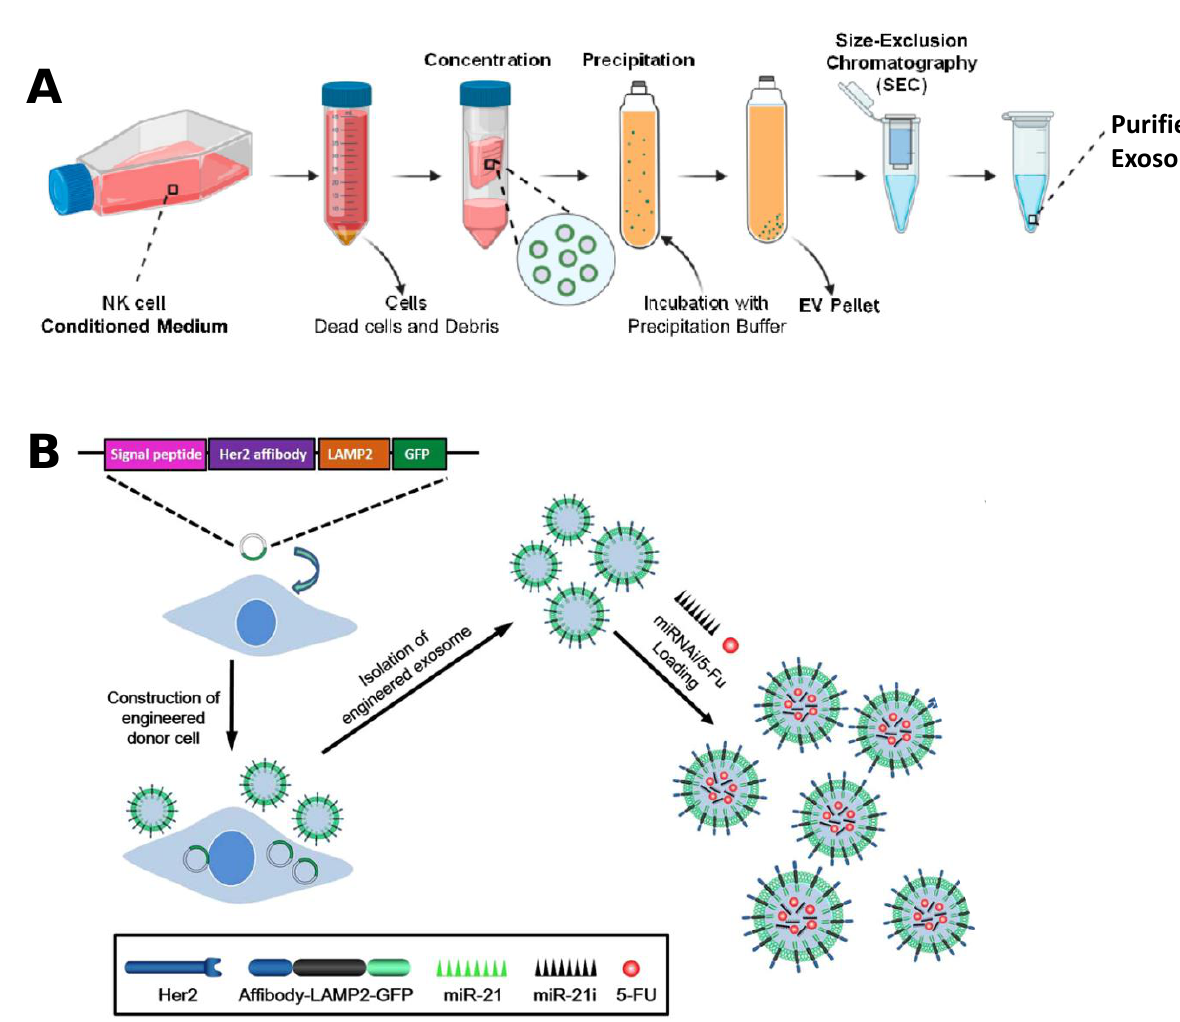
Figure 3. ( A ) The diagram describes the NKExos production process diagram. After 72 h of culture, NK92MI cells were removed by differential centrifugation. Finally, NKExos was concentrated and purified [92]. Copyright: © 2021 by the authors. ( B ) Preparation flow chart of engineered exosome nanocapsules based on 5-FU and Mir-21i. Her2 fuses with LAMP2 to form HCT-116 5FR cells. Her2-lamp2 fusion protein promotes targeted cellular uptake through EGFR receptor-mediated endocytosis in HCT-116 cells. 5-FU and Exo were mixed by electroporation, and 5-FU and Mir-21i were packaged into engineered exosomes and incubated together to form a co-delivery system (THLG-EXO/5-FU/Mir-21I) [93]. Copyright 2020, Springer Nature. Exosomes have more prominent features than LNPs including nucleic acid delivery, protection of therapeutic substances from degradation, elimination by the host immune system, and etc. In addition, the characteristic of exosomes derived from their parental cells give them the potential for targeted delivery and enhance their ability to penetrate the tumor vascular barrier and bioaccumulate at tumor sites, greatly improving their therapeutic bottleneck. More importantly, exosomes have shown amazing feasibility as drug delivery vehicles in many preclinical studies and several clinical trials. From this point of view, the future of exosome-based delivery systems will break new ground in cancer